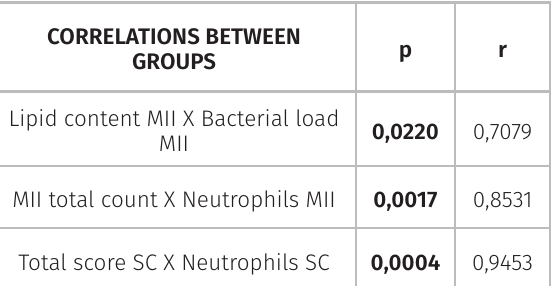
Table I. Bacterial load correlate with lipid content in exercise